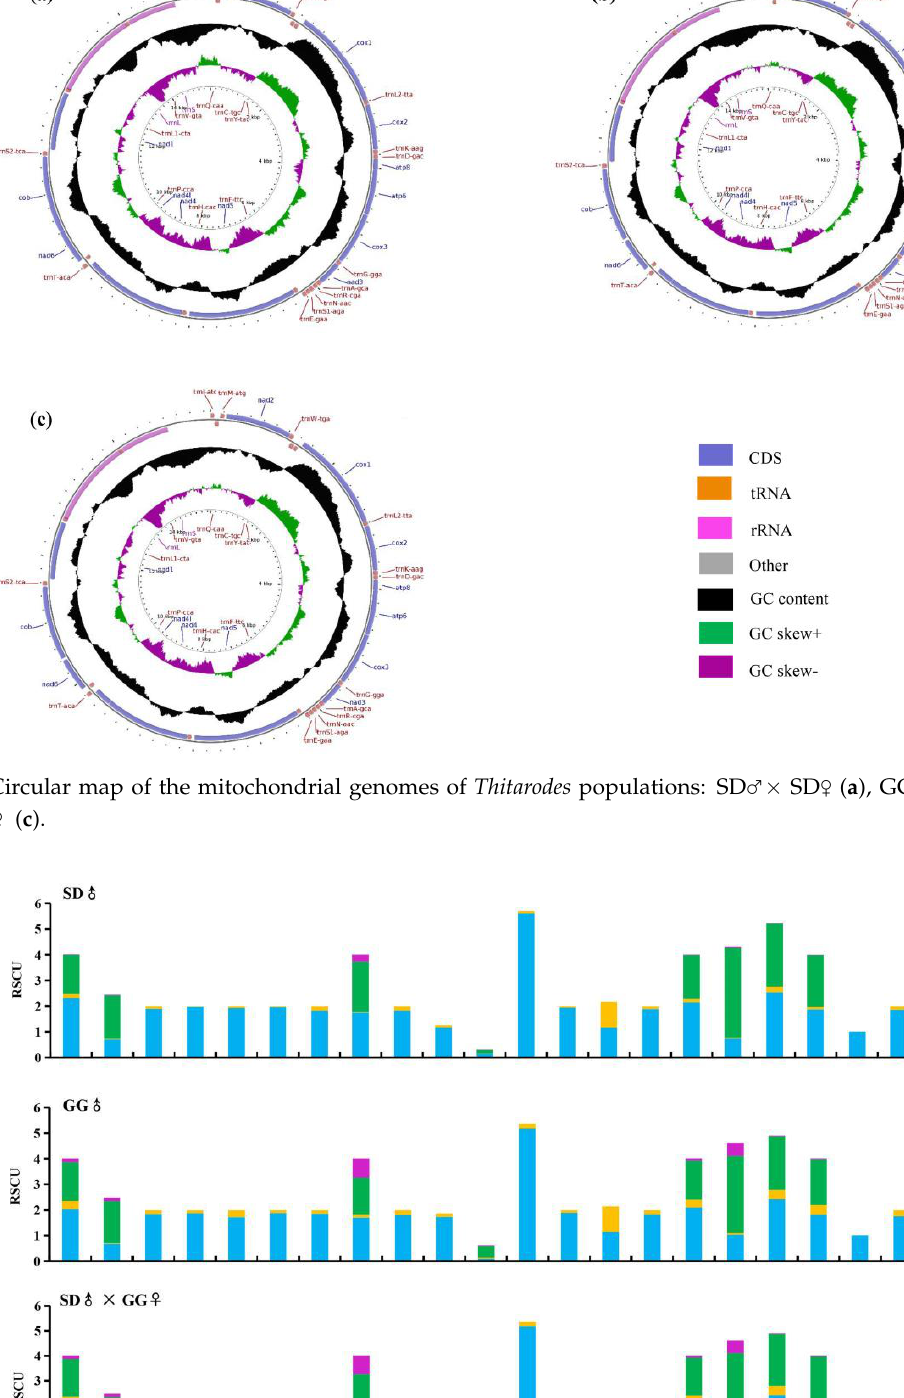
Table 2. Comparison of the complete mitochondrial genomes of three Thitarodes populations.